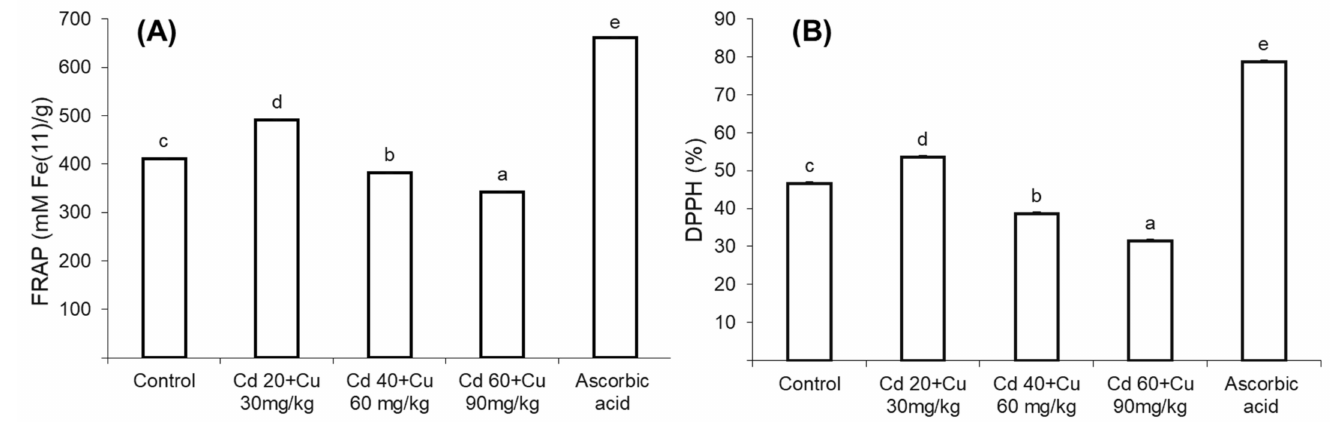
Figure 2. The impact of different Cd and Cu stress concentrations (0, Cd 20 + Cu 30 mg/kg, Cd 40 + Cu 60 mg/kg, and Cd 60 + Cu 90 mg/kg) on the shoot’s FRAP ( A ) and DPPH ( B ) contents of pigeon pea plants. Bars represent means from the three independent replicates ( ± , n = 3); different letters indicate significant differences between the treatments at p < 0.05.